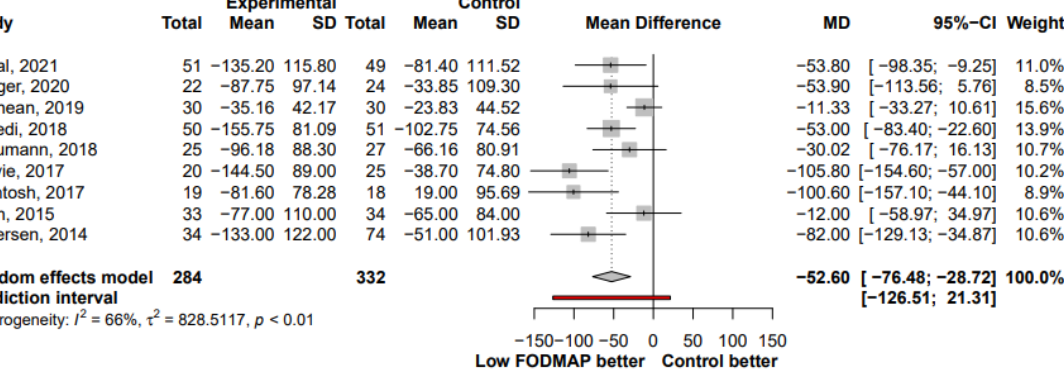
Figure 3. Forest plot showing mean IBS ‐ SSS reduction in studies that used pre ‐ and post ‐ intervention IBS ‐ SSS measures. SD, standard deviation; MD, mean difference; CI, confidence interval .